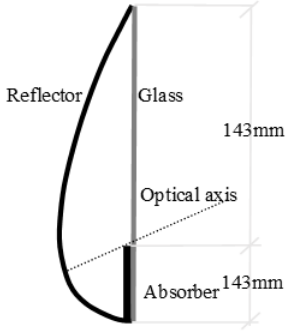
Figure 7. Diagram of wall MaReCo designed for south facing with optical axis at 25° from the horizon [23].